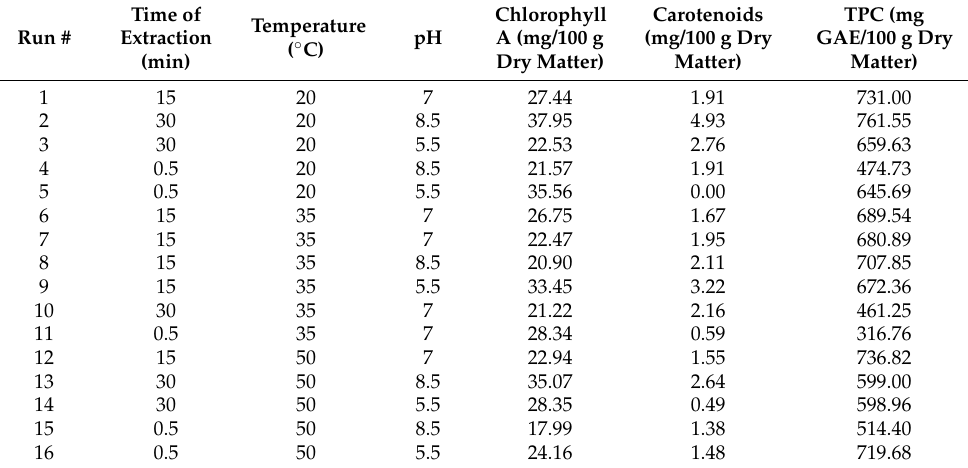
Table 3. Chlorophyll A, total carotenoids (mg/100 g dry matter) and total phenolic compounds (TPC) (mg GAE/100 g dry matter) obtained after ultrasound-assisted extraction at different times, temperatures and pH levels. GAE: Gallic Acid Equivalent